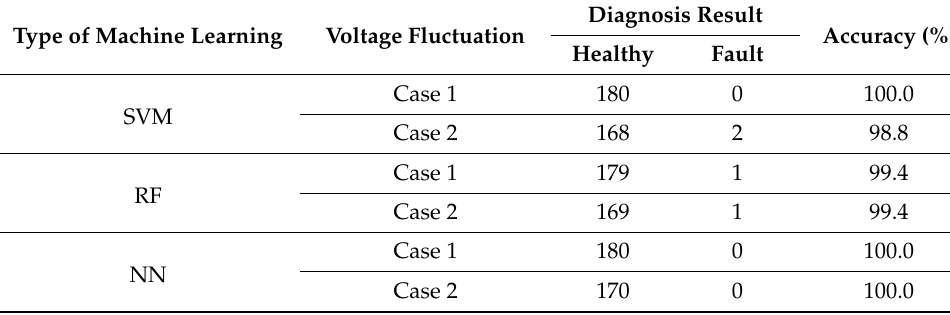
Table 8. Diagnosis result for No. 7 motor based on machine